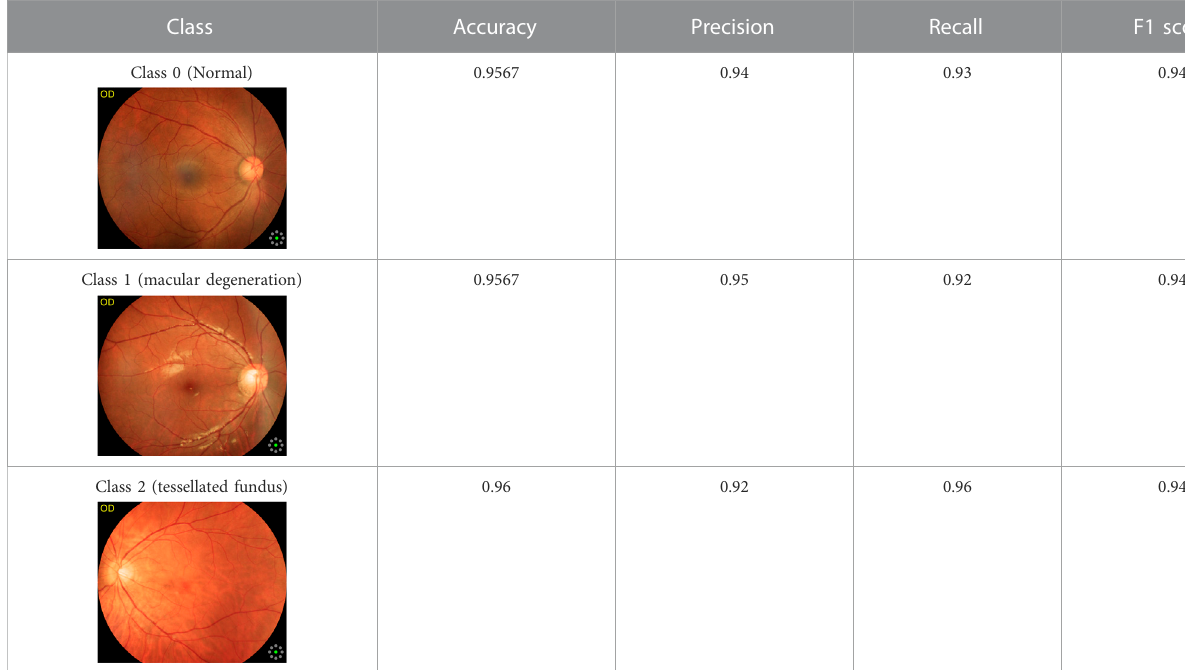
TABLE 4 Performance evaluation for each class using.